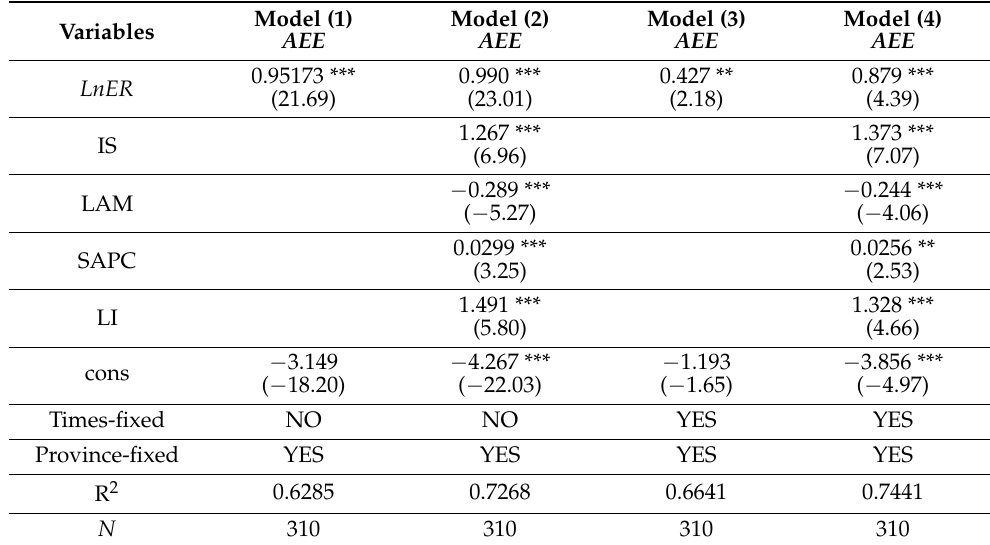
Table 2. Benchmark regression model analysis.